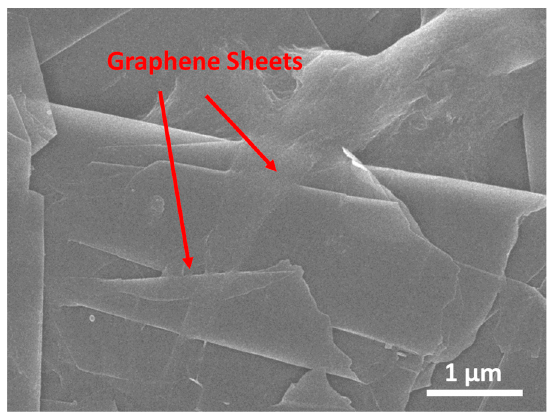
Figure 3. SEM image of the spray-on graphene/PVP sensor with 1.0 wt.% graphene.